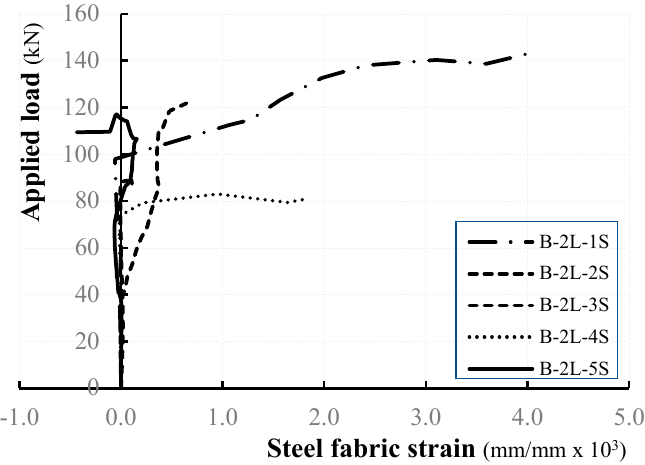
Figure 16. Load–steel bar strain curves for beams strengthened with two-layer SRG strips.